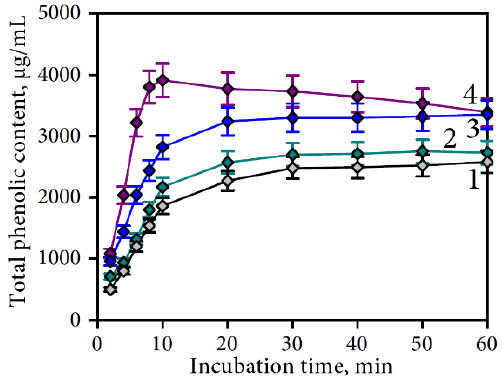
Figure 4. Effects of extraction media on the total phenolic compounds yield. Media: 1 —water; 2 —0.2% NaCl/water, pH 6.8, 3 —0.2% NaCl/water, pH 2.0 (HCl); 4 —pepsin (400 U/mL)/0.2% NaCl/water, pH 2.0 (HCl).